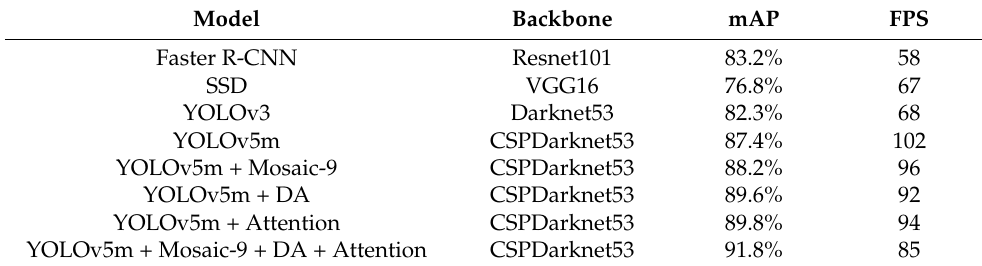
Table 2. Experimental results with different models and loss functions.